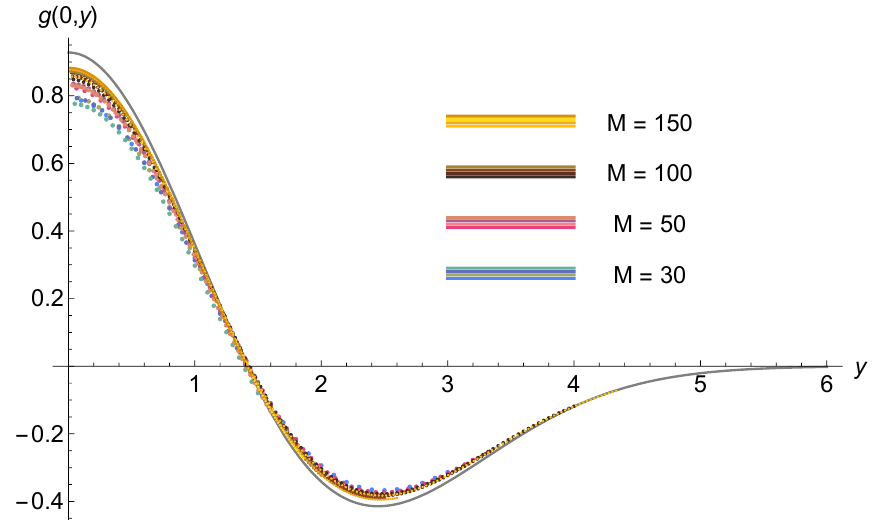
Figure 3: Plot of the numerically calculated (dots) scaled one-point smoothed- curvature correlation function g ( 0, y ) , obtained by (25) from C ( 0, ∆ E ) , as a function of y = ∆ E /(cid:34) , compared with the exact large- M asymptotic (64) (solid curve). Dots of different colours correspond to different matrix sizes M , and several energy win- = 0. The colours next to each value of M represent, dow widths (cid:34) , all centered at E 0 from bottom top, data for (cid:34)/π = 0.33,0.42,0.5,0.67 ( M = 30), 0.31,0.38,0.5,0.63 ( M = 50), 0.25,0.3,0.4,0.5 ( M = 100), and 0.23,0.38,0.54,0.69 ( M =